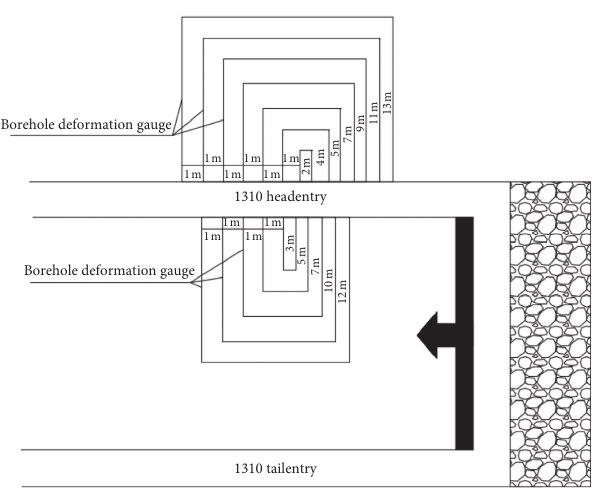
Figure 23: Layout of abutment pressure measuring points.